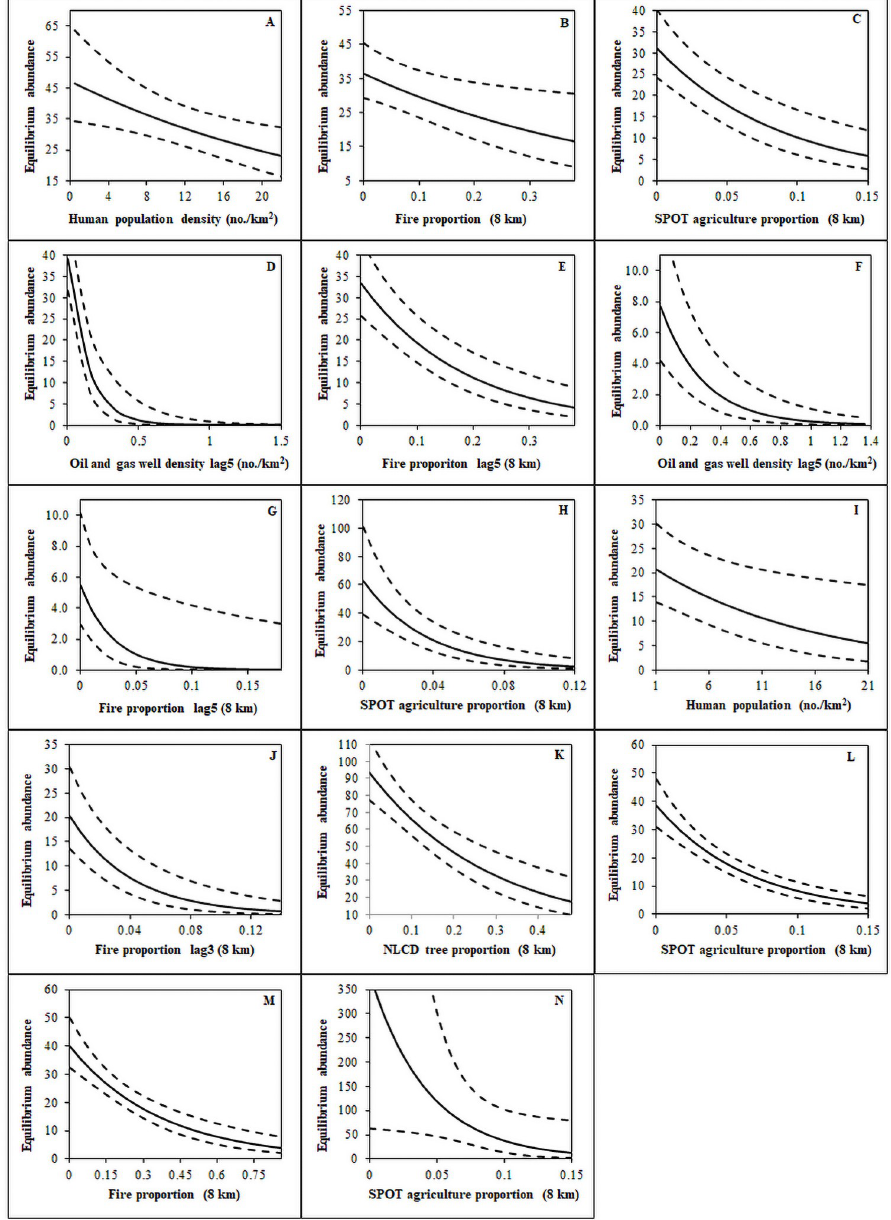
Fig 5. Predicted effects of anthropogenic, fire, and habitat variables on equilibrium abundance ( K ) from open population N-mixture models (Gompertz or Ricker density-dependent models). Variables are labeled on the x-axis and refer to the following regulation histories: Never 1995 ((A) top Δ AIC model and (B) second Δ AIC model); Never 1996 (C), (D), and (E); First-Year (F) and (G); Permit (H), (I), and (J); Upland (K); Study-Continuous (L) and (M); and Study-Discontinuous (N). Male count data were collected by states and provinces throughout the western United States and southern Alberta and Saskatchewan Canada from 1995–2013.